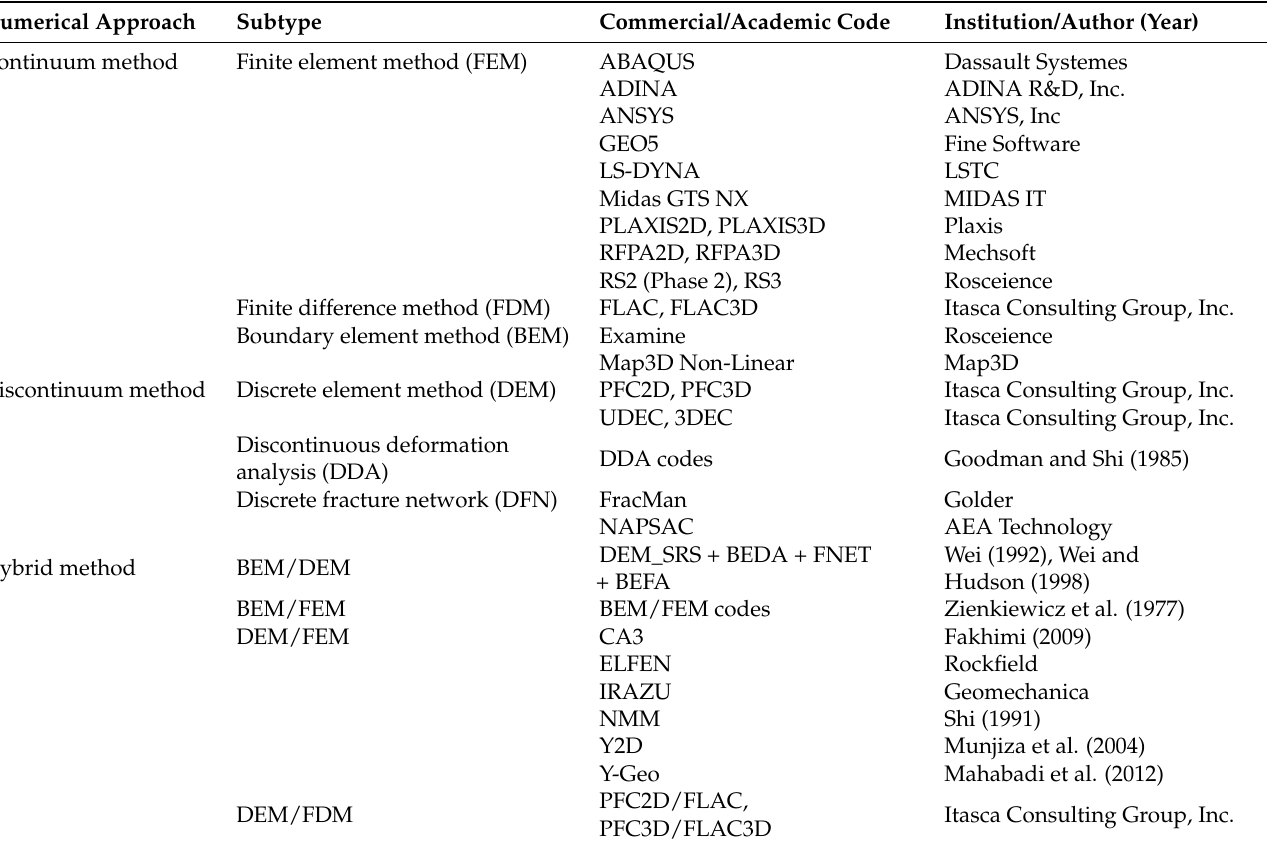
Table 2. Summary of numerical analysis